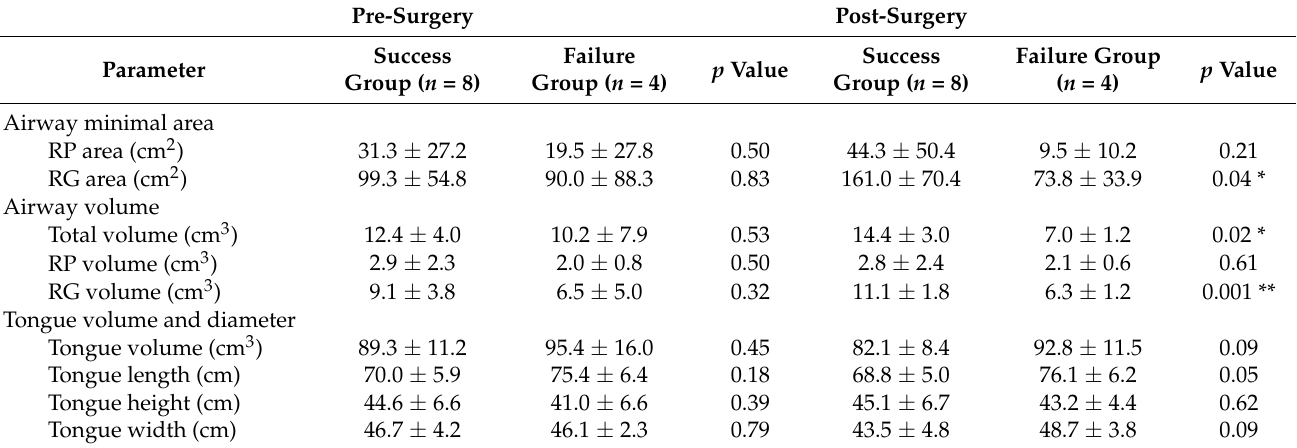
Table 3. The success group versus the failure